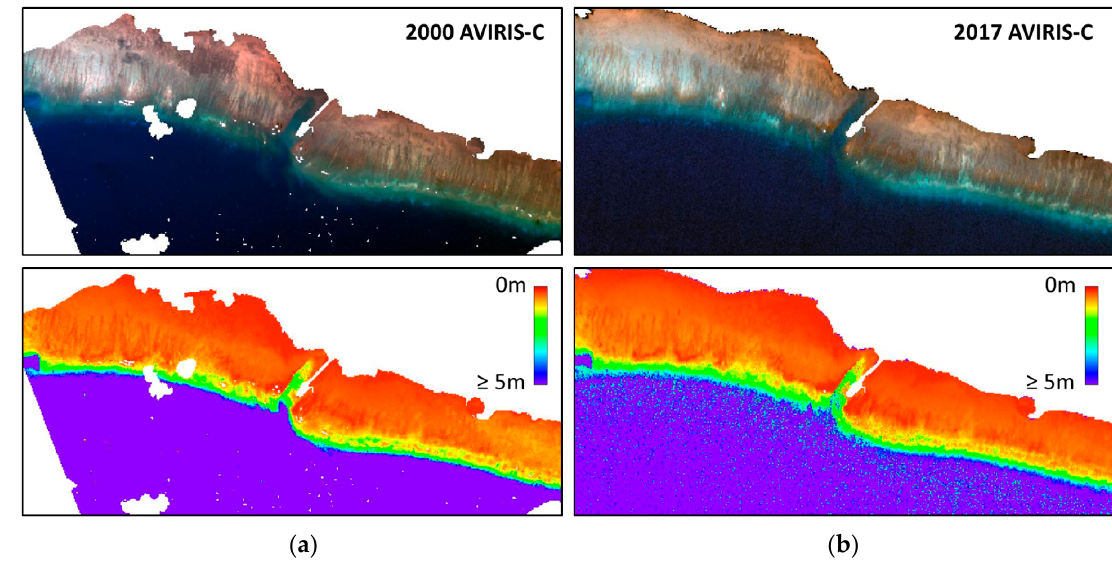
Figure 5. Derived bathymetry for 2001 and 2017 Molokai data at 18 m spatial resolution: ( a ) 2001 true-color image and derived water depth; ( b ) 2017 true-color image and derived water depth. Areas with no data and masked areas of land, cloud, cloud shadow, and wave breaks are shown in white. Table 3. Statistical comparison of hyperspectral derived bathymetry between di ff erent years of acquisition for Kaneohe Bay, Molokai, and French Frigate Shoals (FFS) at 18 m spatial resolution; with linear correlation coe ffi cient, r, and mean di ff erence, m, for depth range from 0–15 m. Negative mean di ff erence values indicate underestimations, and positive values indicate overestimations of derived water depth as compared to the image in a given